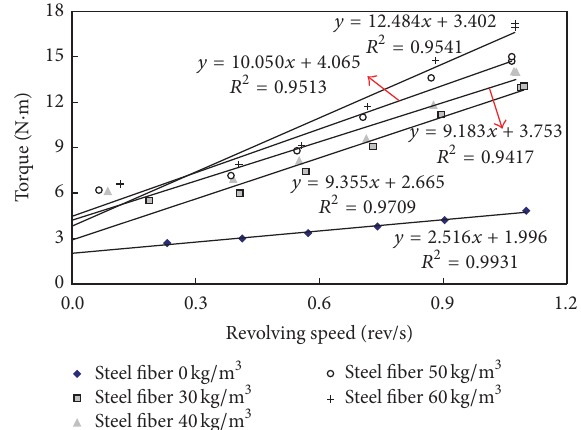
Figure 9: Exerted torque versus rotational speed relationship steel fiber mixtures with 9.1%